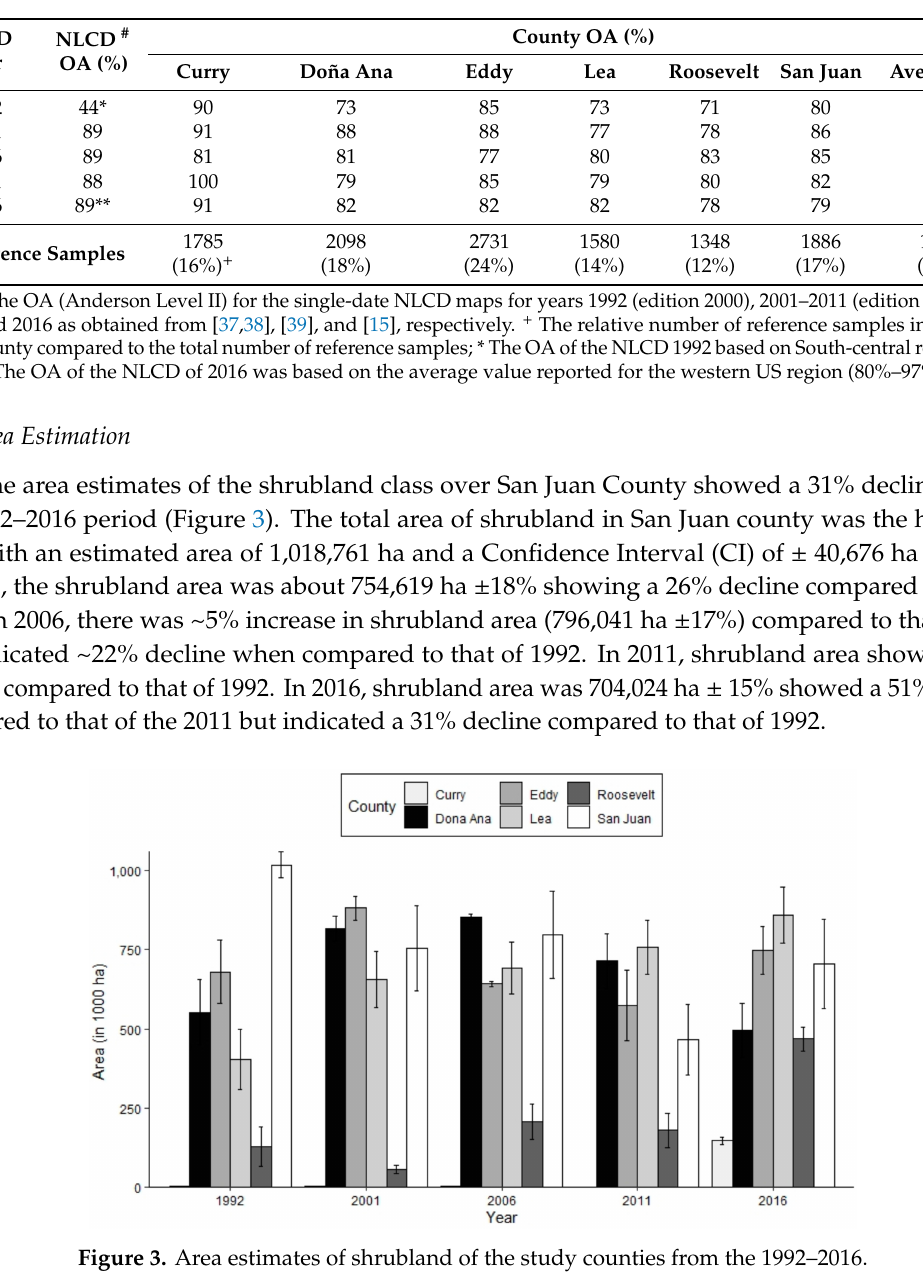
Table 7. A summary of the obtained overall accuracy (OA) based on SEPAL at the county level compared to those reported with the NLCD maps at the national / regional level.